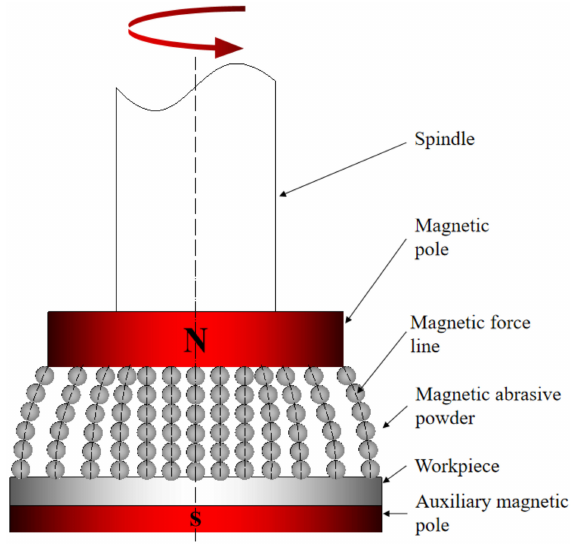
Figure 1. Schematic drawing of planar